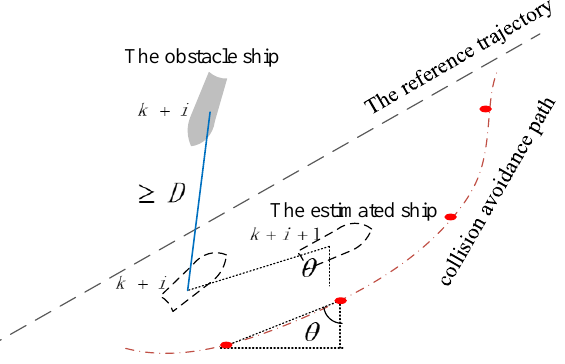
Figure 3. The distance correlation model between the ship and obstacle ship.